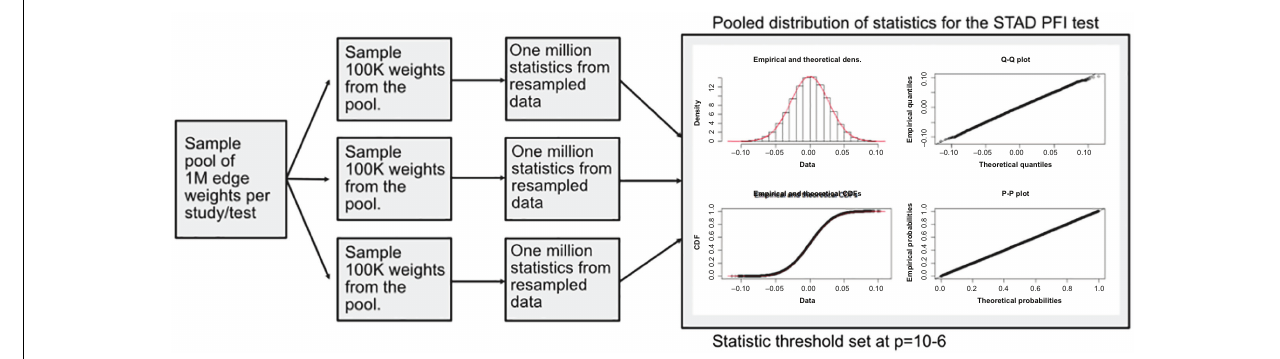
FIGURE 4 | Diagram of the resampling procedure for calculating differentially weighted edges. Three sample pools of edge weights were taken from each tissue source. Then matching the sample sizes for clinical features, edge weight samples were used in computing randomized S 1 statistics. For each sample pool, tumor type, and phenotype combination, 1 million statistics were produced, and the millionth percentile on combined statistics (3M total) was used as a cutoff in determining important edges.